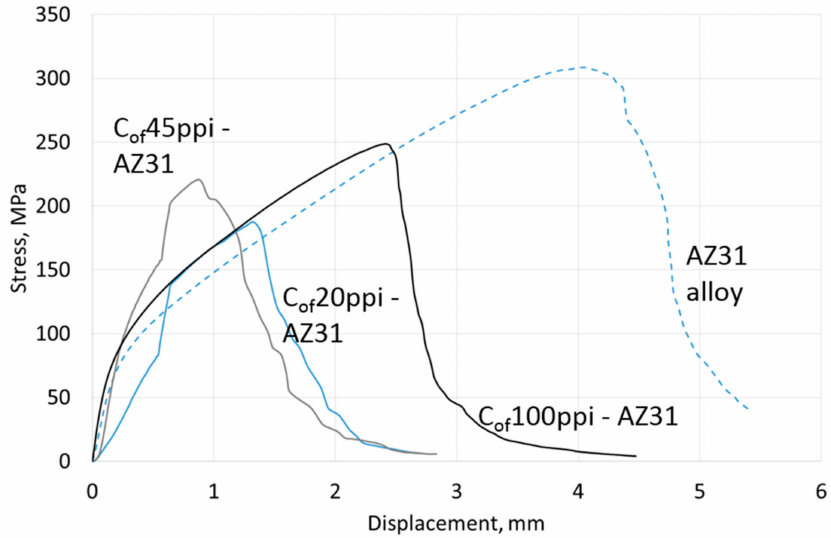
Figure 13. Representative curves obtained from three-point bending tests of AZ31 matrix composites with C of 20ppi, C of 45ppi and C of 100ppi.